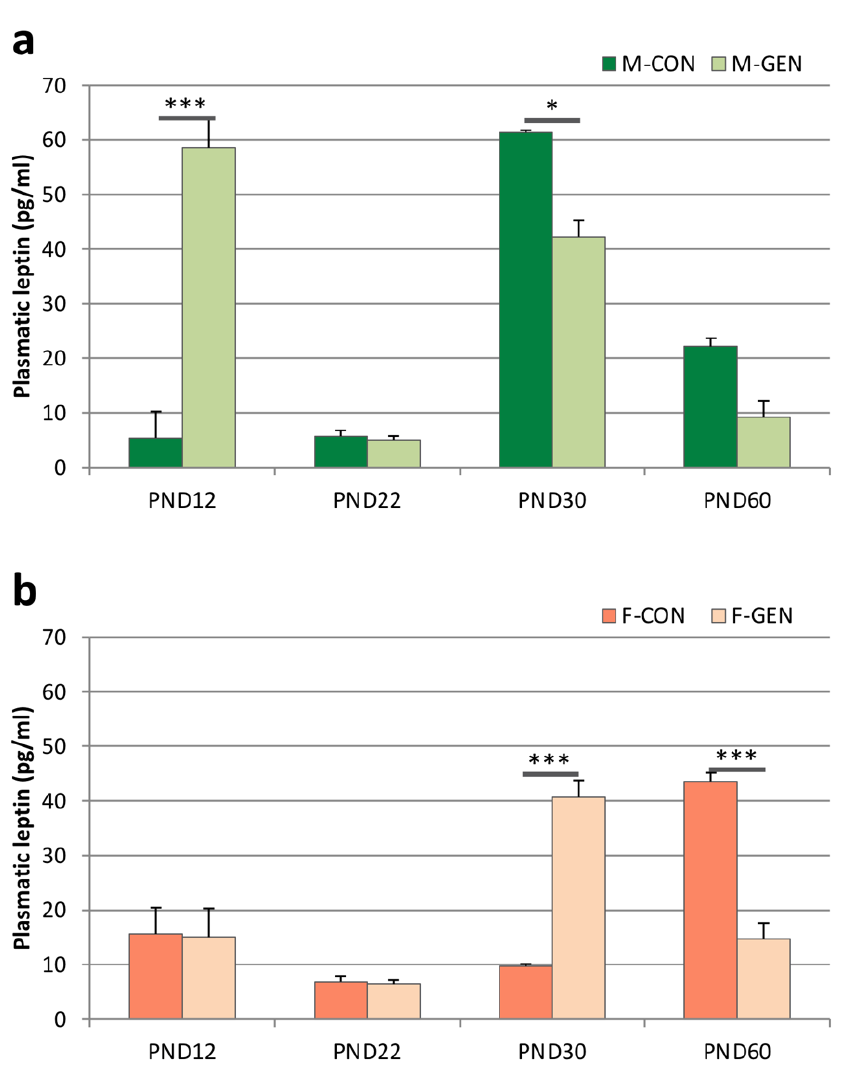
Figure 3. Leptin levels. Histograms representing variations of circulating leptin levels (expressed in pg/mL; mean ± SEM) in males ( a ) and females ( b ), control (CON) and treated (GEN), during the development at postnatal day (PND) 12, PND22, PND30, and PND60. * p < 0.05; *** p ≤ 0.001 (Tukey test).